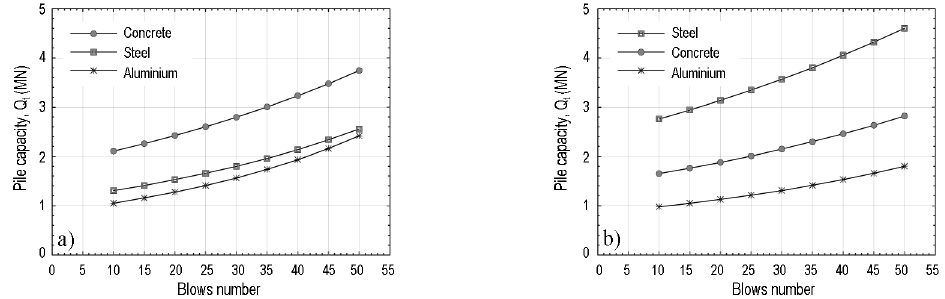
Fig. 14. Effect of blows number on pile capacity: (a) Large-displacement pile, (b) Low-displacement pile